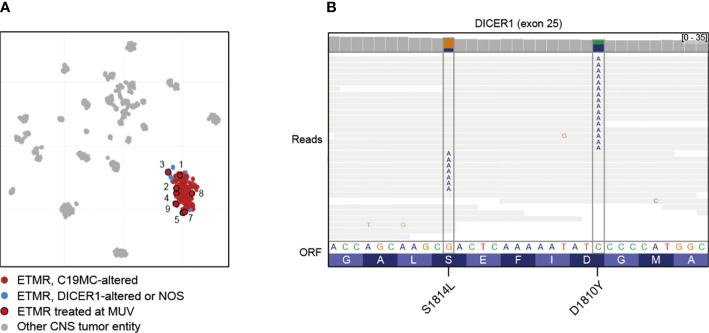
Molecular characterization of treated cases. (A) Clustering of ETMRs treated at MUV using t-Stochastic neighborhood embedding with 193 ETMRs (12), 534 other CNS tumors (37) and 44 pineoblastomas (13). Case 6 was not included due to low tumor content. (B) Mutual exclusivity of mutations affecting DICER1 exon 25 in case 3, suggesting that the mutations are biallelic. Lines represent reads; substitutions are annotated in the reads at the appropriate position.